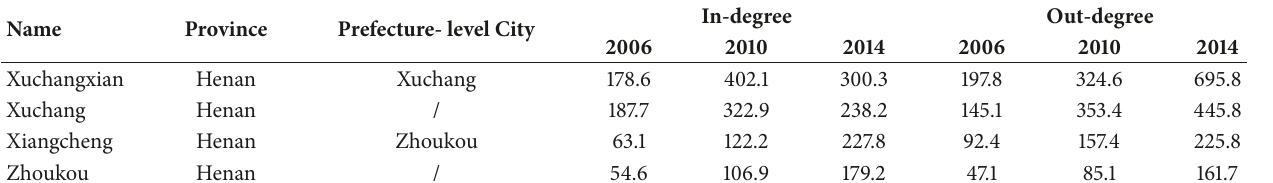
Table 4: Statistical table of several cities of the HRB.